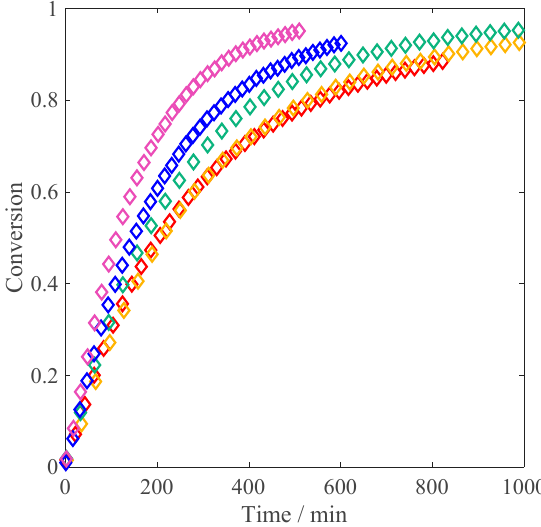
Figure 6. Monomer conversion versus time profiles of the radical batch polymerization of fully ionized MAA in aqueous solution at 50 °C, 0.1 wt % of V ‐ 50 initiator, initial monomer concentration equal to 5 wt %, without addition of salt (red), salt addition to obtain an ionic strength equivalent to a monomer concentration of 10 wt % (yellow), 15 wt % (green), 20 wt % (blue), and 30 wt % (purple).